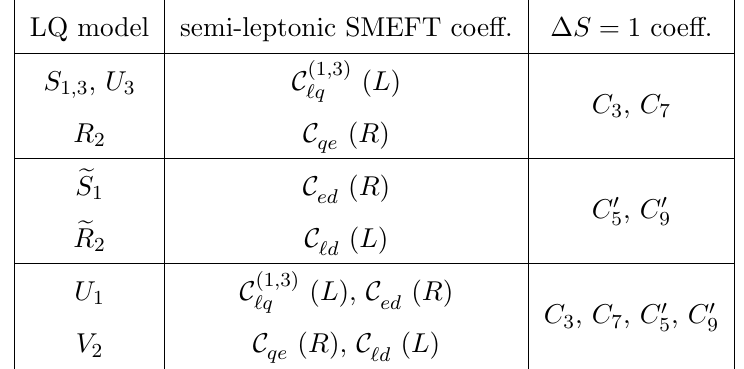
Table 2. Classi(cid:12)cation of LQ models corresponding to their contribution to " 0 =" via EW gauge- mixing and the involved semi-leptonic Wilson coe(cid:14)cient. The chirality of the LQ couplings entering the semi-leptonic Wilson coe(cid:14)cients is shown in parenthesis, see appendix B for details. p where v 2 = ( 2 G ) (cid:0) 1 and c (cid:17) cos (cid:18) . We used the approximation (3.37). These F W W